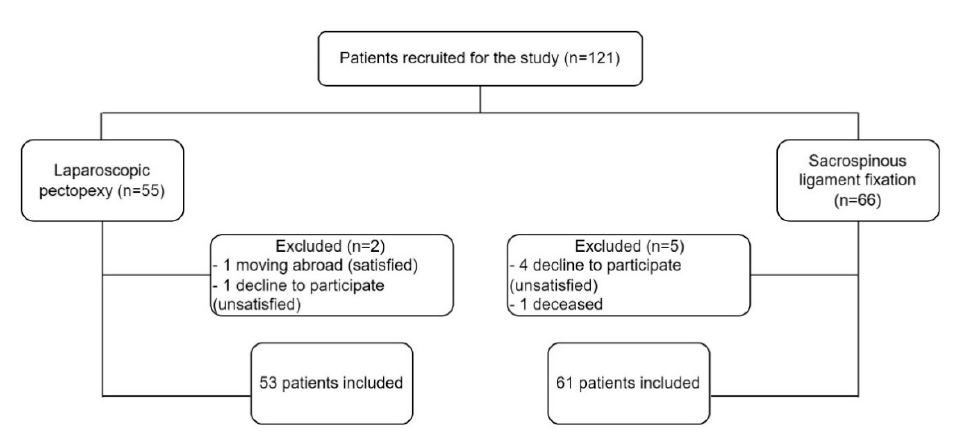
Figure 1. Study flowchart.